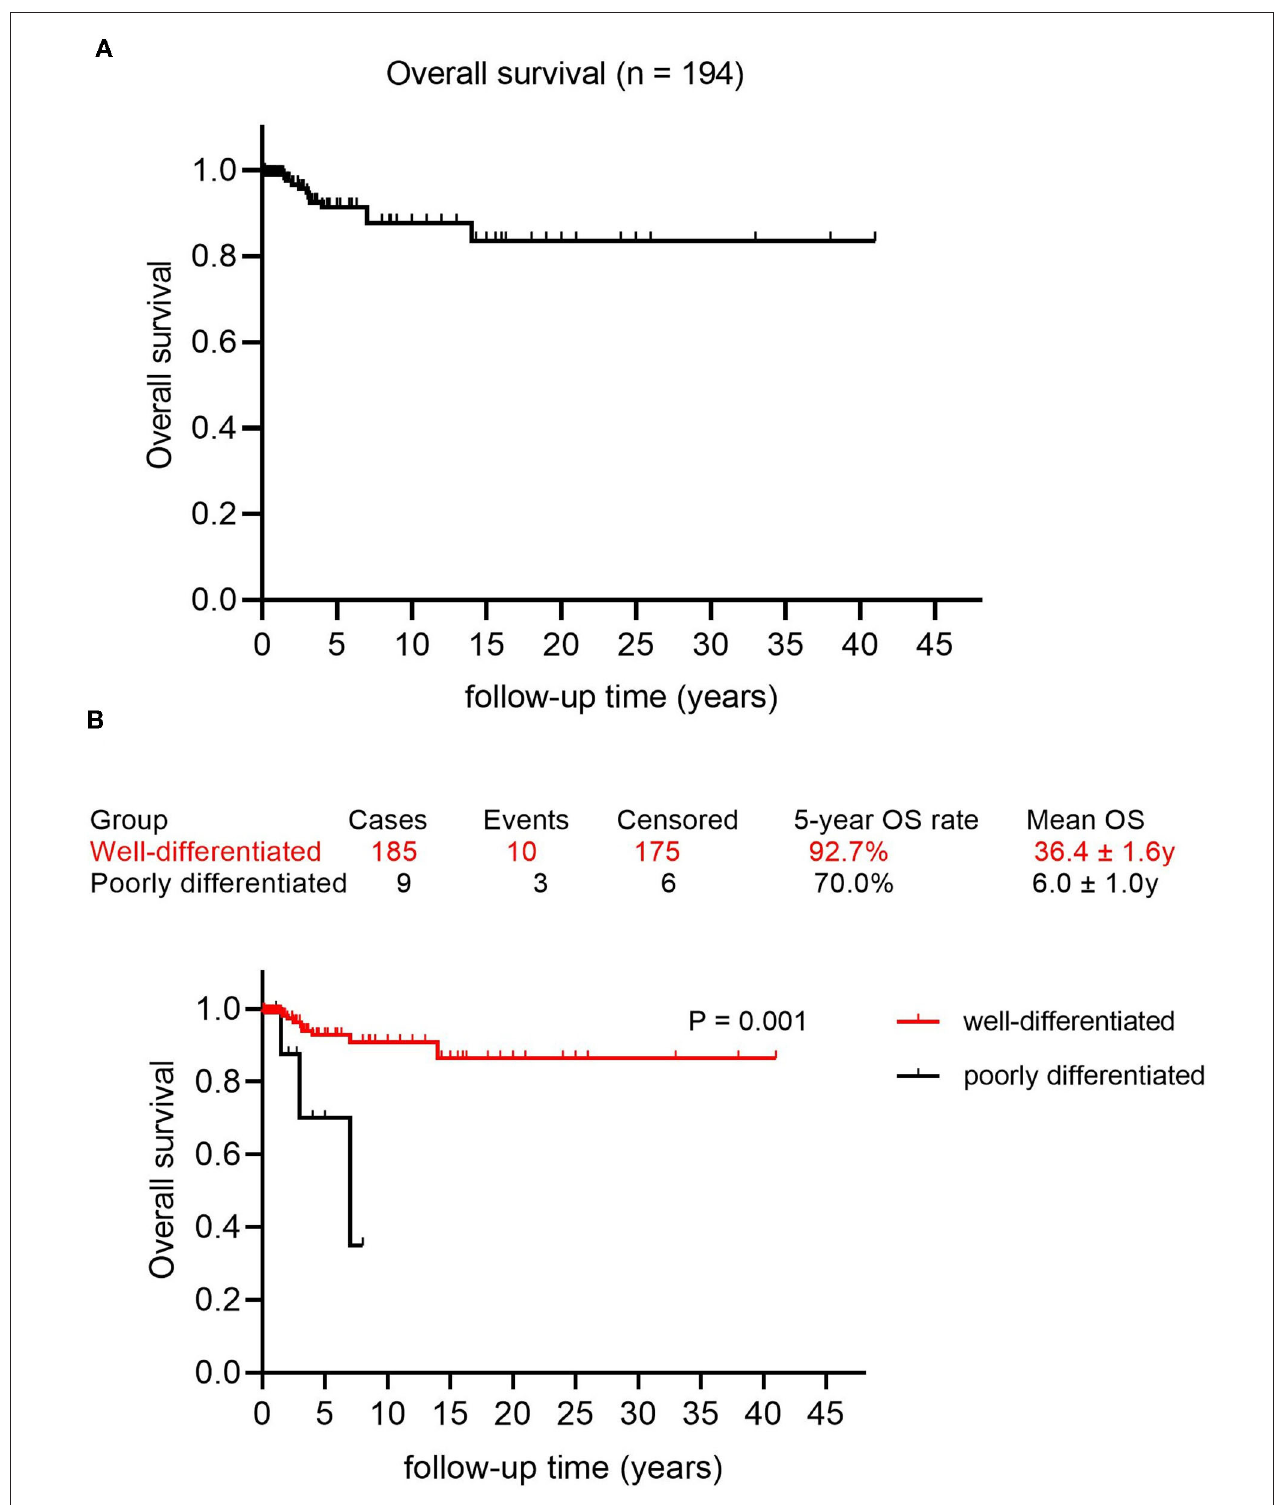
FIGURE 2 | Survival curves in patients with malignant struma ovarii (MSO). (A) Overall survival curve in this study. (B) The Kaplan–Meier (log-rank) test showed a significantly different OS rate between patients with well-differentiated MSO and poorly differentiated MSO ( p = 0.001).